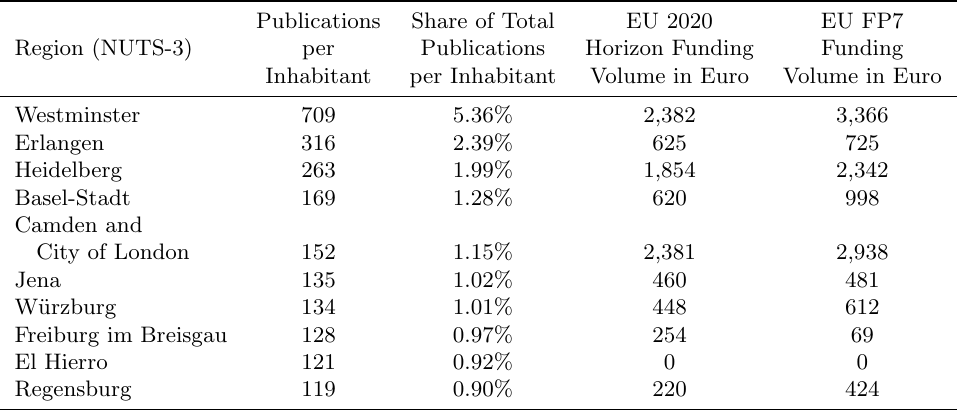
Table 1b: The ten Most Active Regions in Cardiovascular Device Knowledge Output by number of publications per capita,